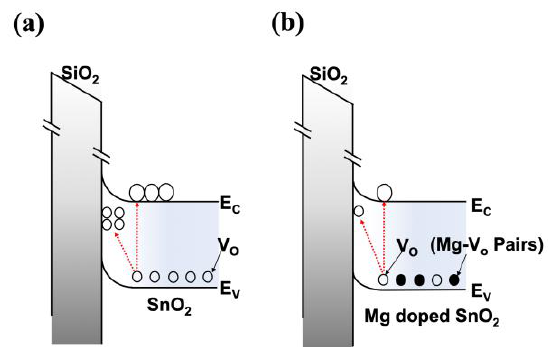
Figure 7. Schematic of the degradation mechanism for ( a ) SnO 2 and ( b ) Mg-doped SnO 2 thin film transistors (TFTs) under negative bias stress (NBS).